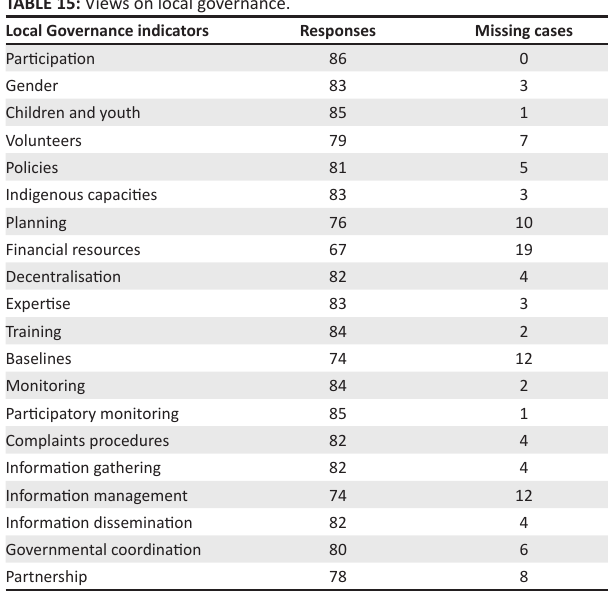
TABLE 15: Views on local